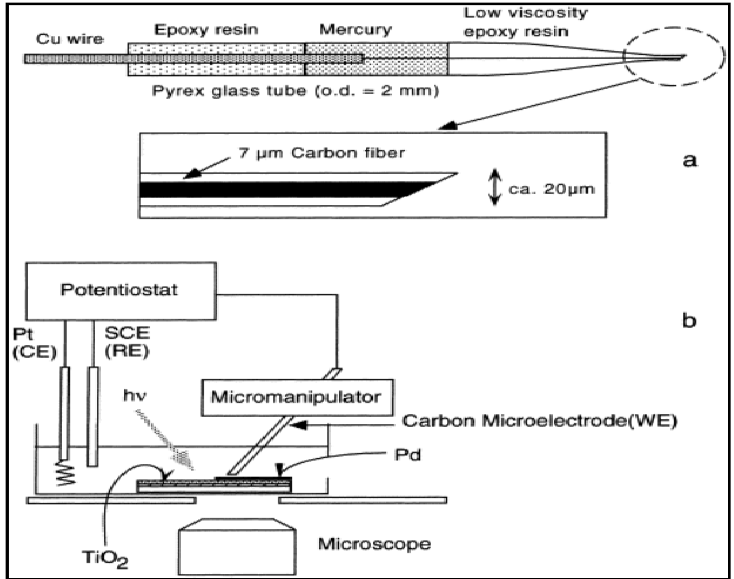
Figure 6. ( a ) The design of carbon microelectrode, ( b ) set-up for simultaneous monitoring of oxi- dation and reduction during E. coli inactivation. Reprinted from [130]. Copyright (2000), with permission from Elsevier.